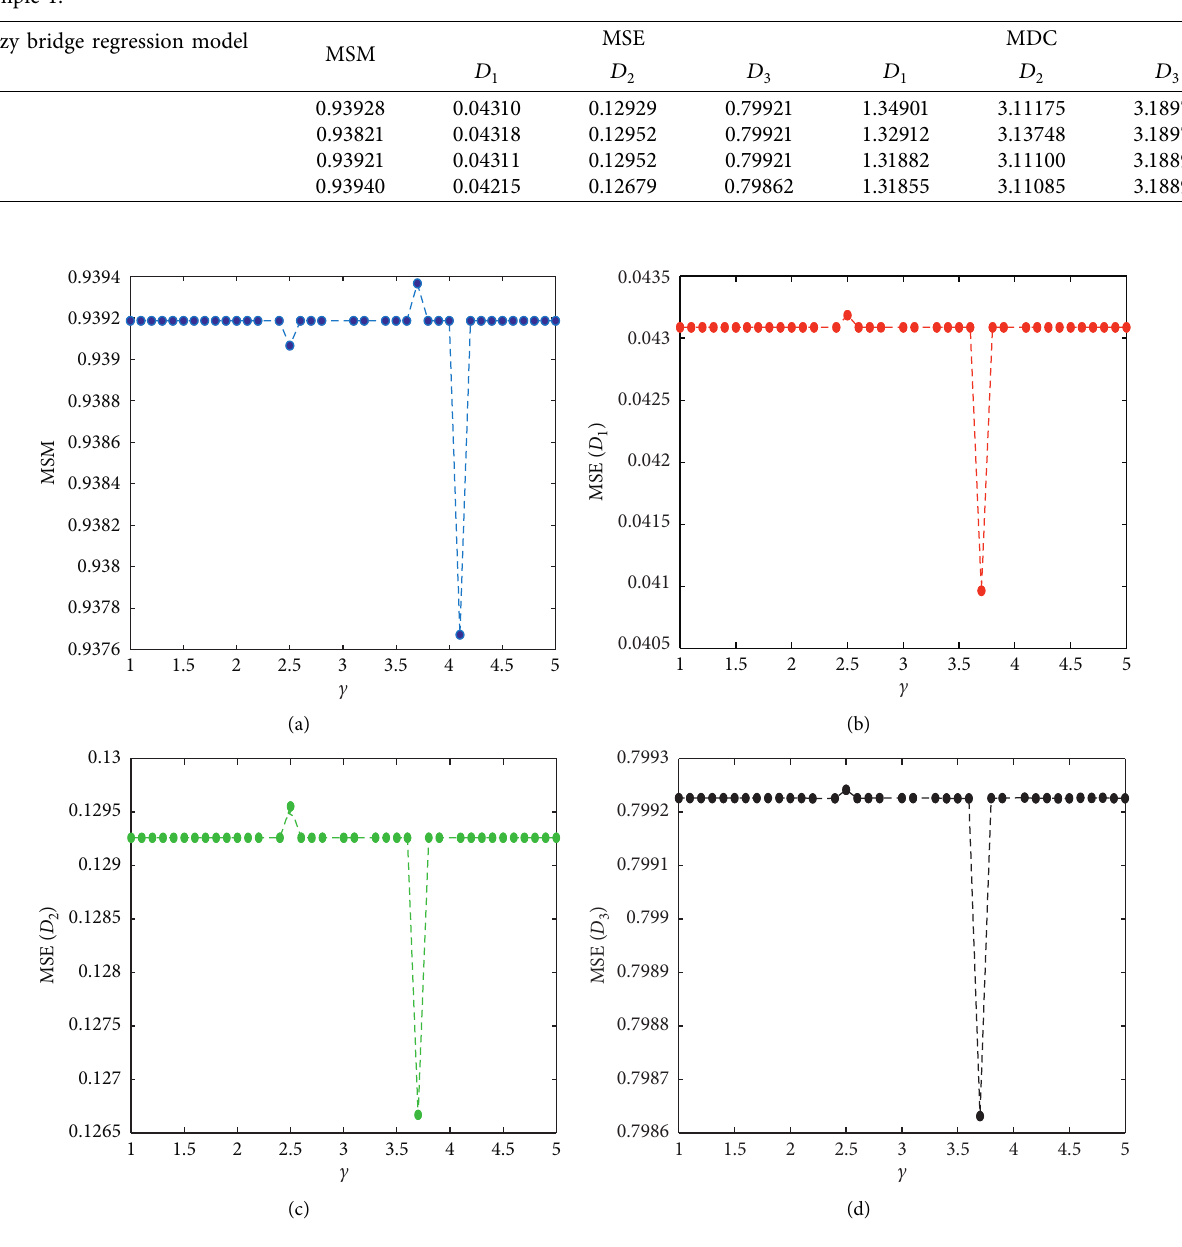
, D , and D in Example 1. (a) MSM index, (b) 1 2 3 3